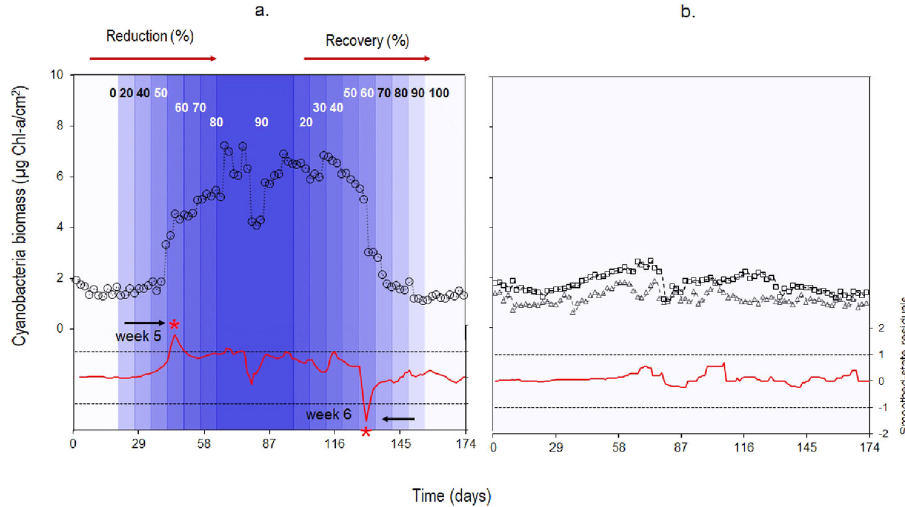
Fig. 3 Benthic cyanobacteria biomass response to experimental manipulations and natural fl ow. a Time-series and smoothed-state estimates (dotted lines) for the experimental site on the manipulated stream (open circles) undergoing reductions and recovery of fl ow (blue shades); b time-series of the upstream reach of the experimental site (squares) and the upstream reach of the control site (triangles) under natural fl ow conditions. Red curves in lower scale correspond to standardized smoothed-state residuals from state-space models for the experimental site and the upstream reach of the control site (the downstream reach shows a similar response to the upstream site as there is no alteration in the stream, see Table 1); dashed black lines are the upper and lower 95% con fi dence intervals, and stars indicate when standardized smoothed-state residuals are beyond the dashed line of con fi dence interval levels.